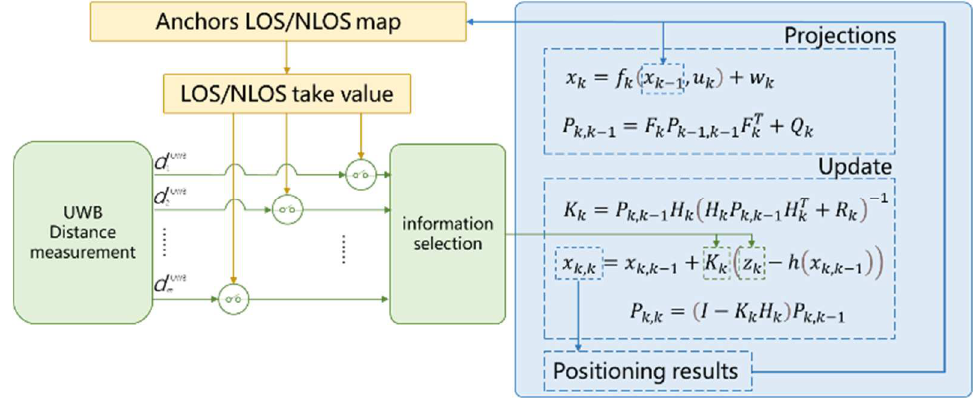
Figure 4. Block diagram of Map-EKF.